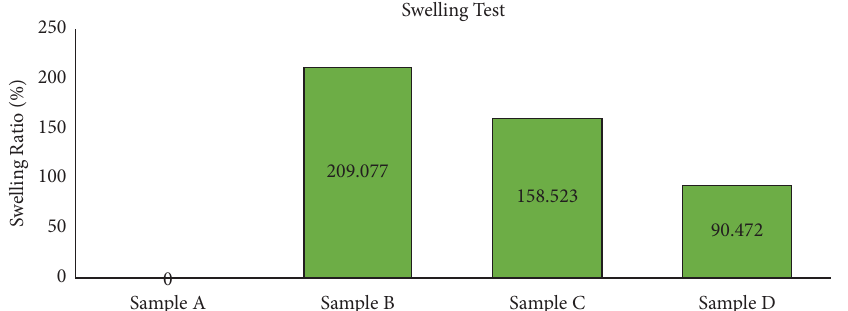
Figure 2: Te swelling test results of hyaluronic acid (HA): chitosan hydrogel with varying composition HA: chitosan sample A (30:0mg/ml), sample B (30:10mg/ml), sample C (30:20mg/ml), sample D